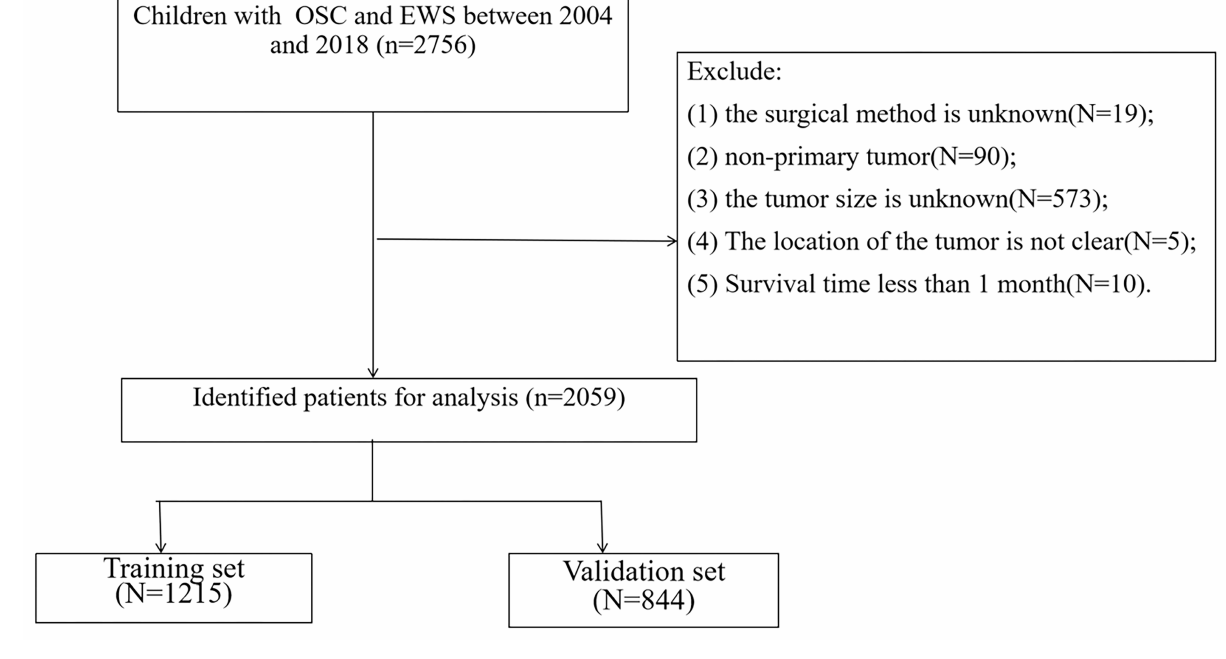
Figure 3 . If they are close to the diagonal, the model has